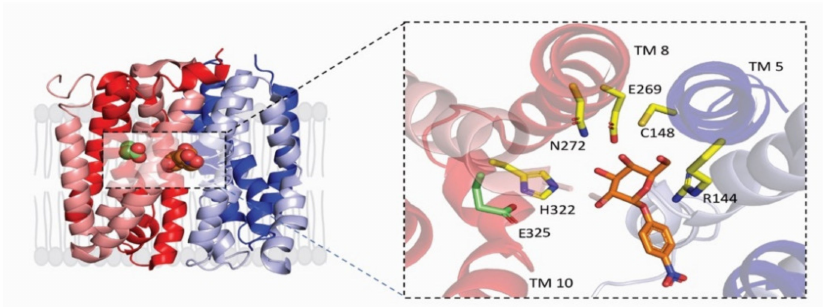
Figure 2. The core domain of the inward-occluded conformation of LacY (PDB: 4ZYR). Side view of LacY in the plasma membrane highlighting the α -NPG binding site. In this orientation, the cyto- plasmic side of the protein is up. The characteristic 6TM repeat is shown in blue (TM1-TM6) and red (TM7-TM12) with the putative protonation site E325 (green) and substrate NPG (orange) spheres. Inset, shows the location of the protonation site E325 (green) in relation to NPG (orange) with their corresponding coordinating residues. The galactosyl subunit of α -NPG is coordinated by H-bonds to side chains on TMs 5, 8 and 10, and hydrophobic stacking to Tyr256 on TM7. Note that two “kinked” (unwound) helices, TM7 and TM10, help accommodate the sugar in the binding site. Atoms are displayed in ball-and-stick form with oxygen colored (red) and nitrogen colored (blue).